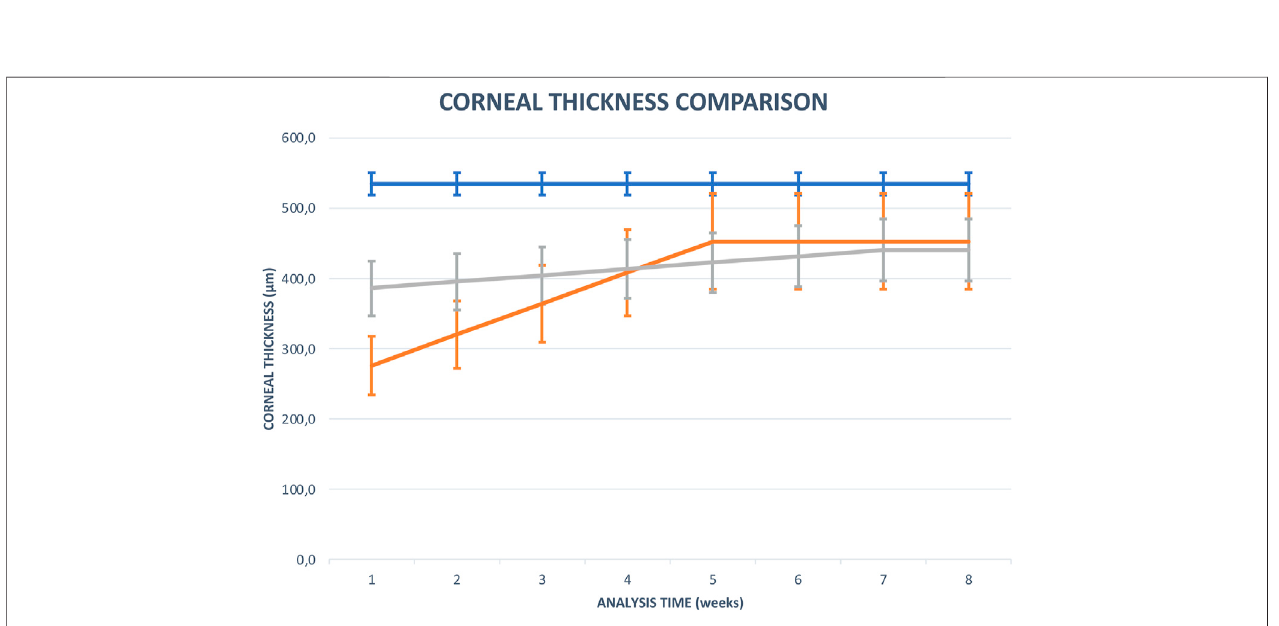
GRAPH 3| Comparison chart of themean CTat each time point during the treatment period (8 weeks) between the cenegermin group (orange line), the ASgroup (gray line), and 16 healthy corneas (blue line).